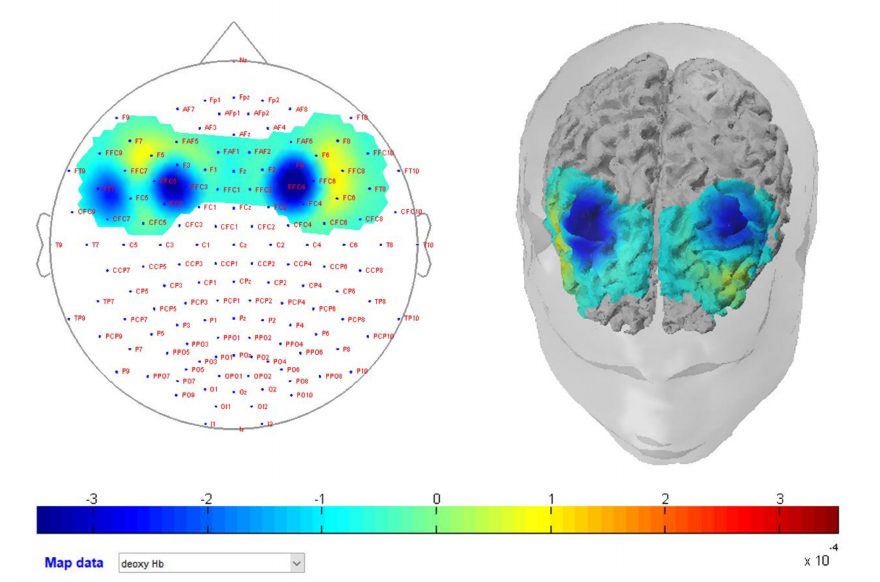
Figure 4. Hemodynamic map of one exemplificative woman participant. The figure shows a decrease in HHb level over the DLPFC during the economic condition. The frame was recorded in response to upside o ff